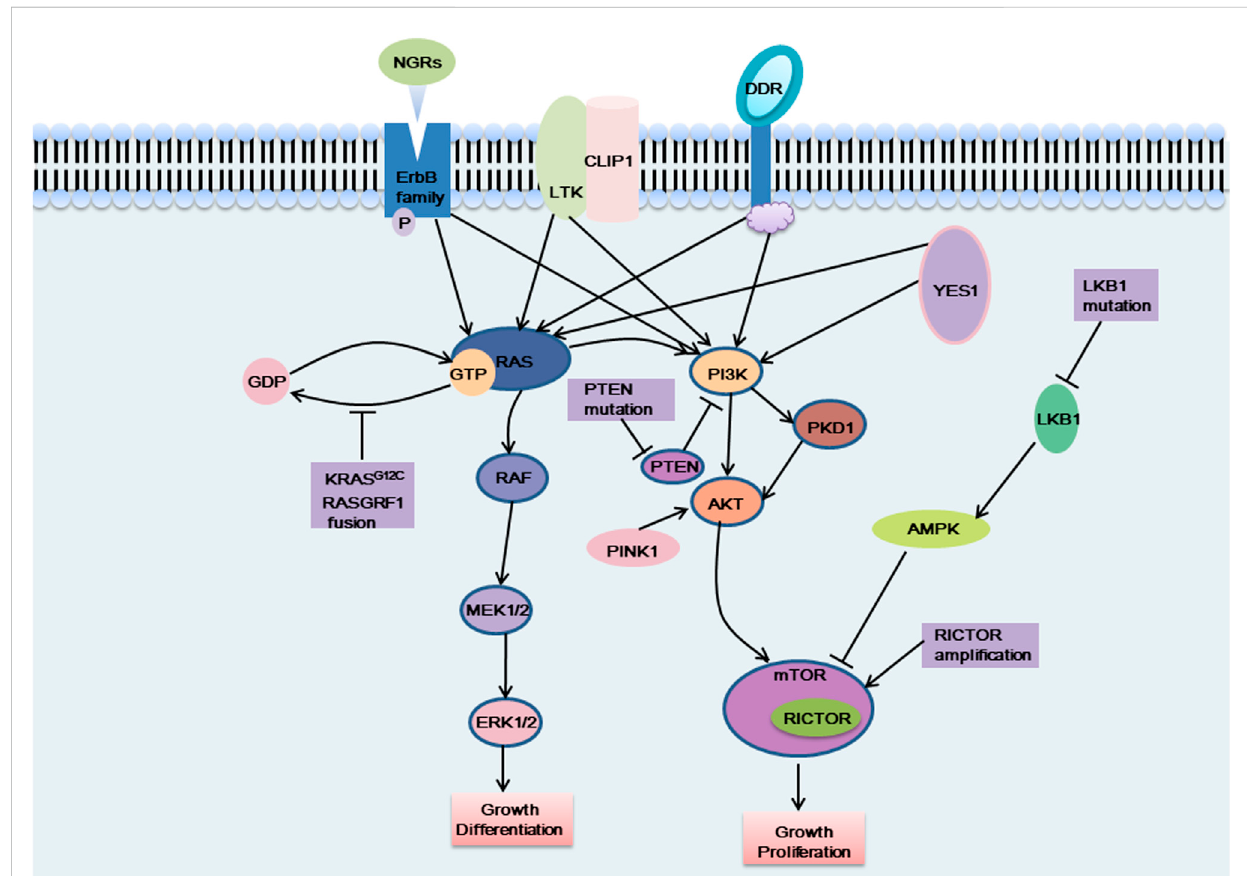
FIGURE 2 The carcinogenic pathways were affected by these emerging targets. NGRs, CLIP1-LTK fusion, DDR mutation and YES1 activate the MAPK pathway and the PI3K pathway, which can affect cell proliferation and differentiation, etc. KRAS G12C mutation and RASGRF1 fusion affect the dissociation of RAS protein from GTP, which in turn activates the MAPK pathway and exerts carcinogenic effects. When PTEN was mutated, the PI3K pathway was continuously activated and exerts carcinogenic effects. PINK1 exerts a carcinogenic effect by activating AKT, thereby activating the downstream signaling pathway. LKB1 cannot activate AMPK when it is mutated, and cannot negatively regulate the mTOR pathway, which, like RICTOR ampli fi cation, causes excessive activation of the mTOR pathway and plays a carcinogenic